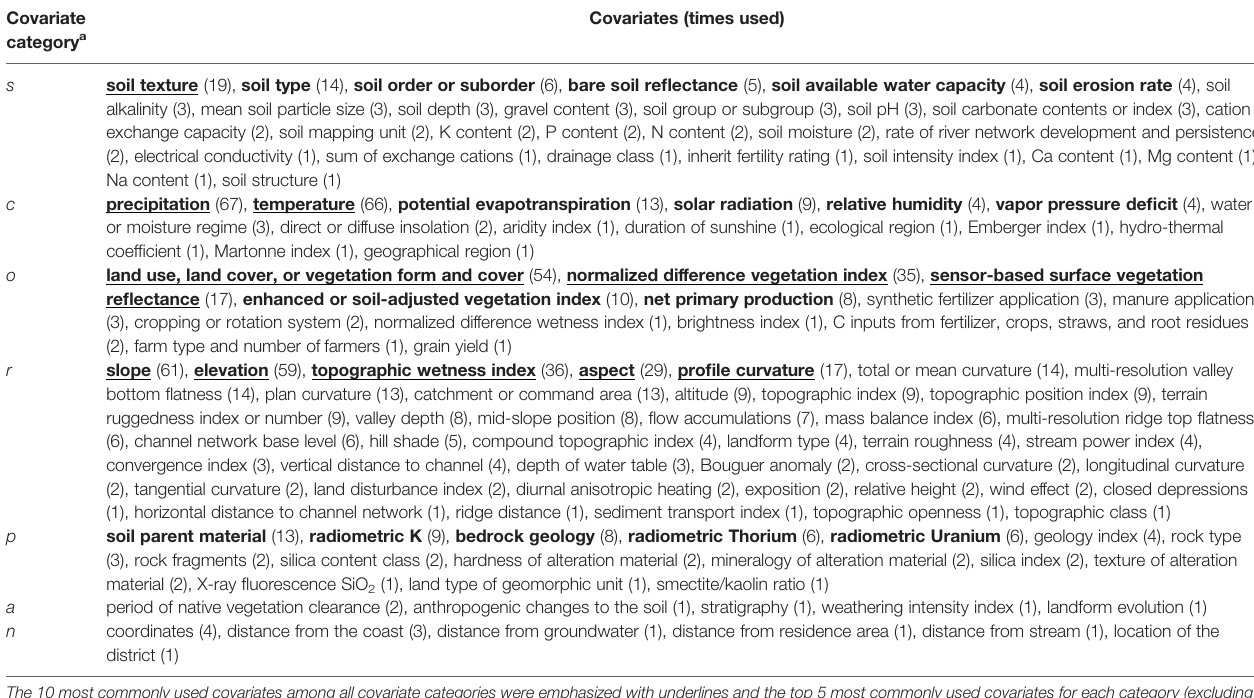
Covariates (times used)